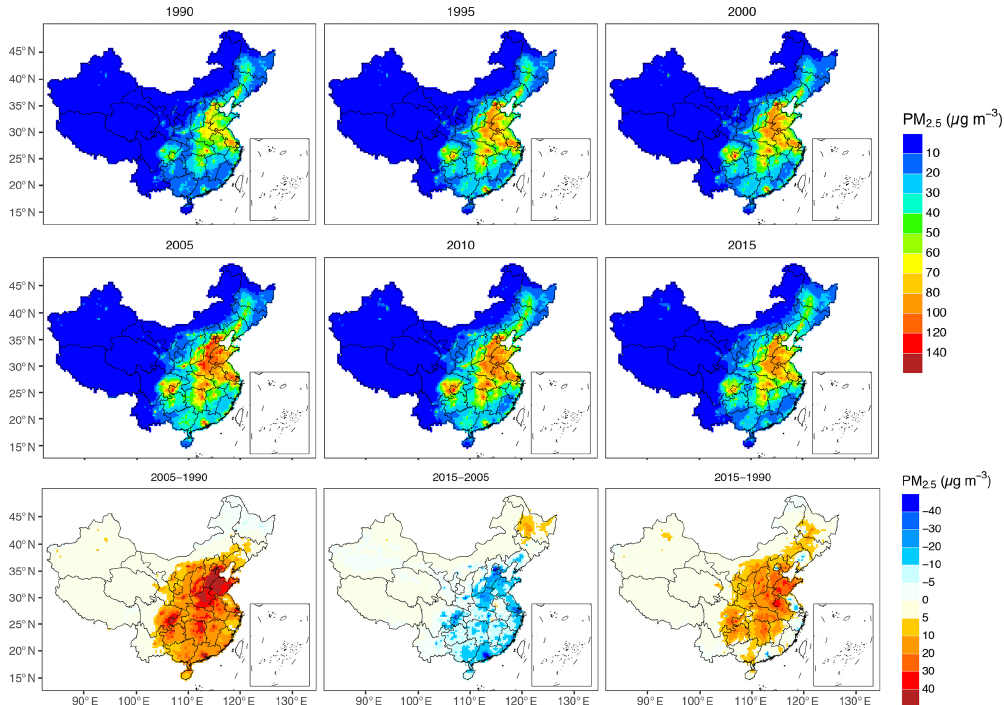
Figure 1. Annual average PM 2 . 5 concentrations and concentration changes from 1990 to 2015 (µgm − 3